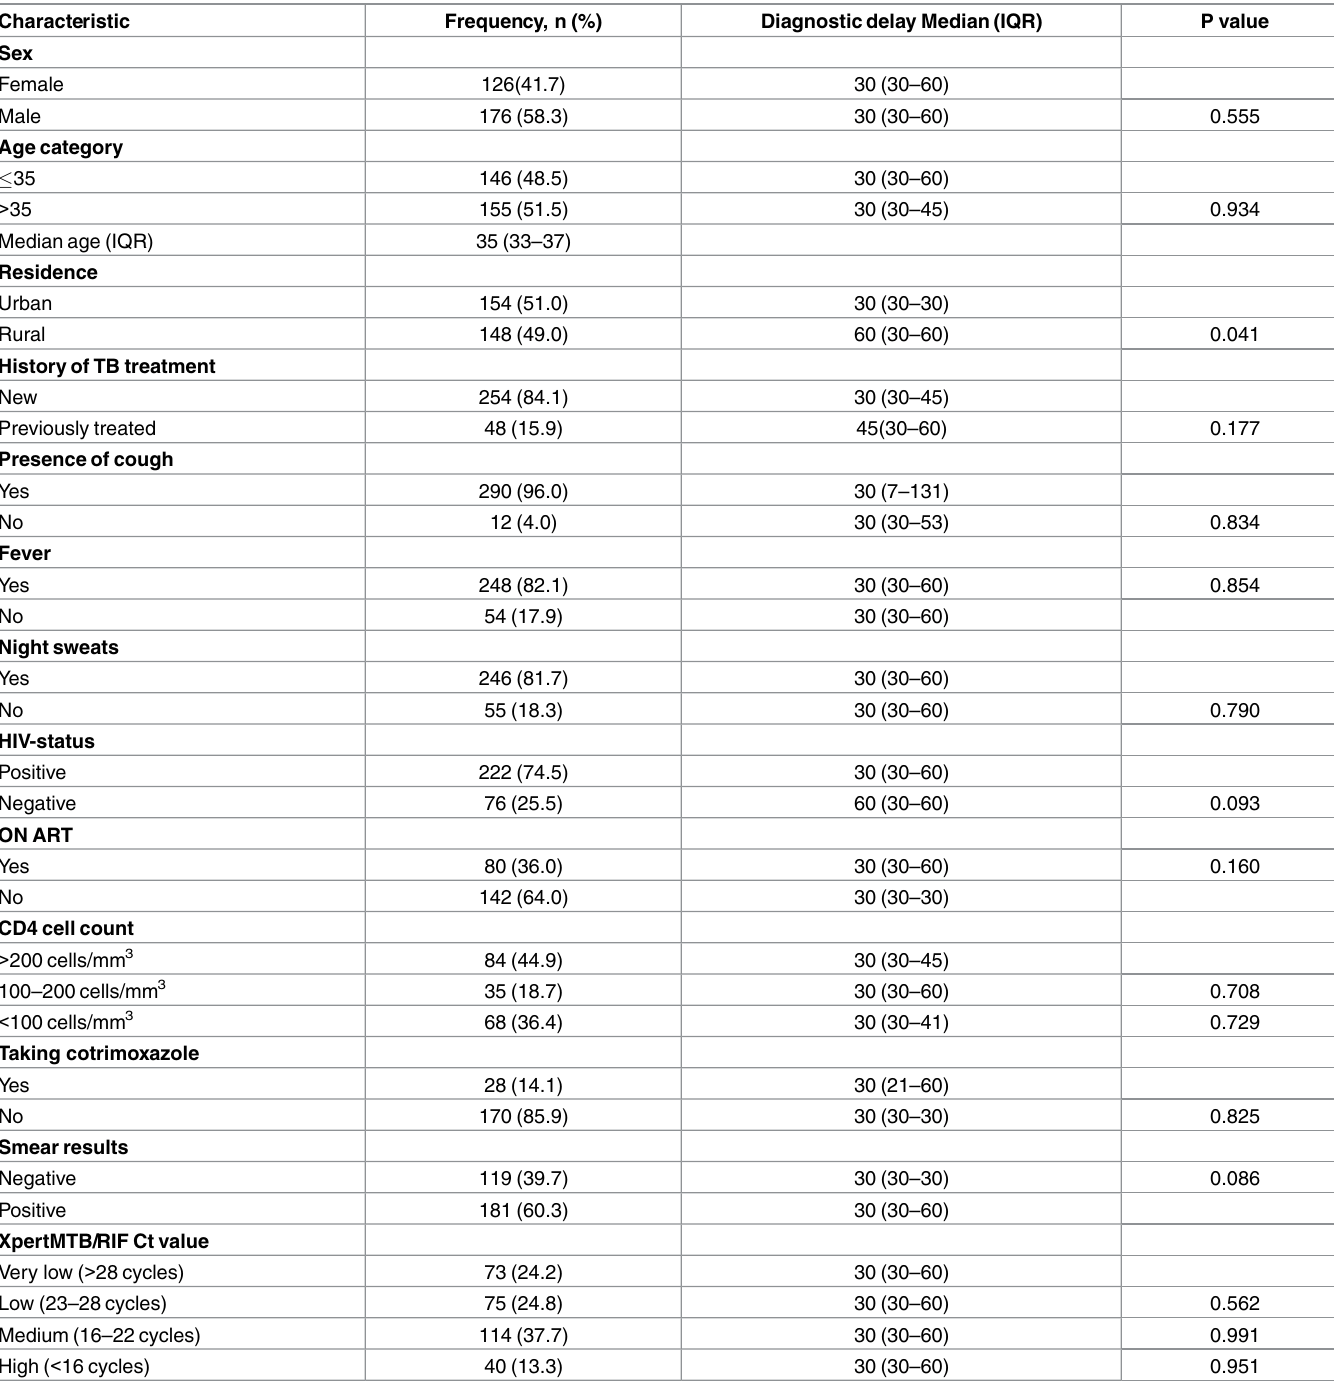
Table 1. Demographic and clinical-demographiccharacteristics and diagnostic delay of pulmonary TB